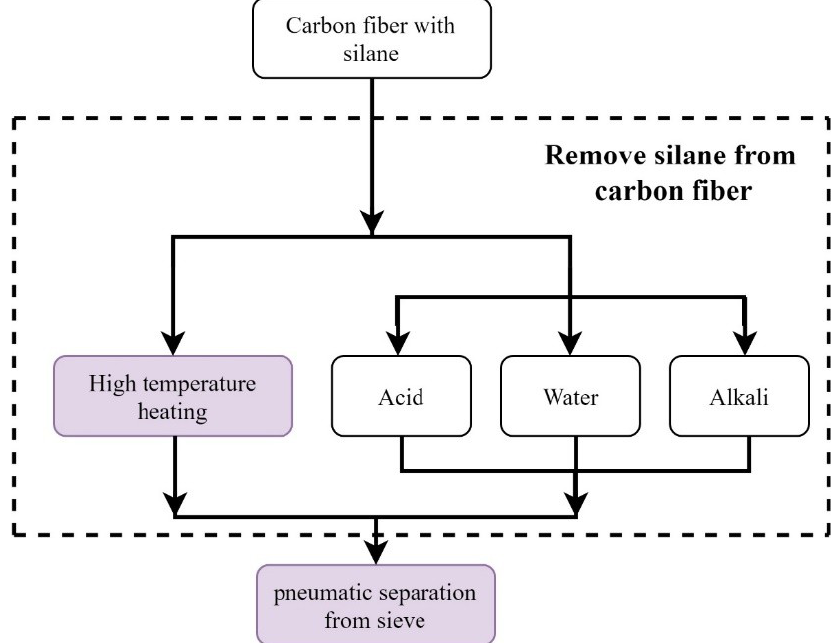
Figure 3. The flowchart of silane removal from short carbon fiber surfaces using different approaches.